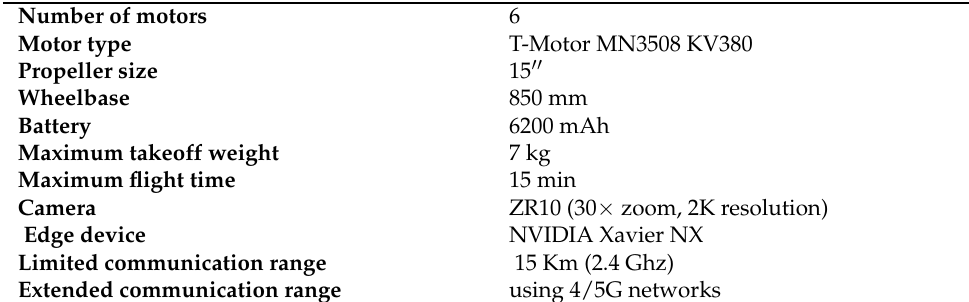
Figure 2. Top view of the custom hexacopter. Table 2. Hexacopter